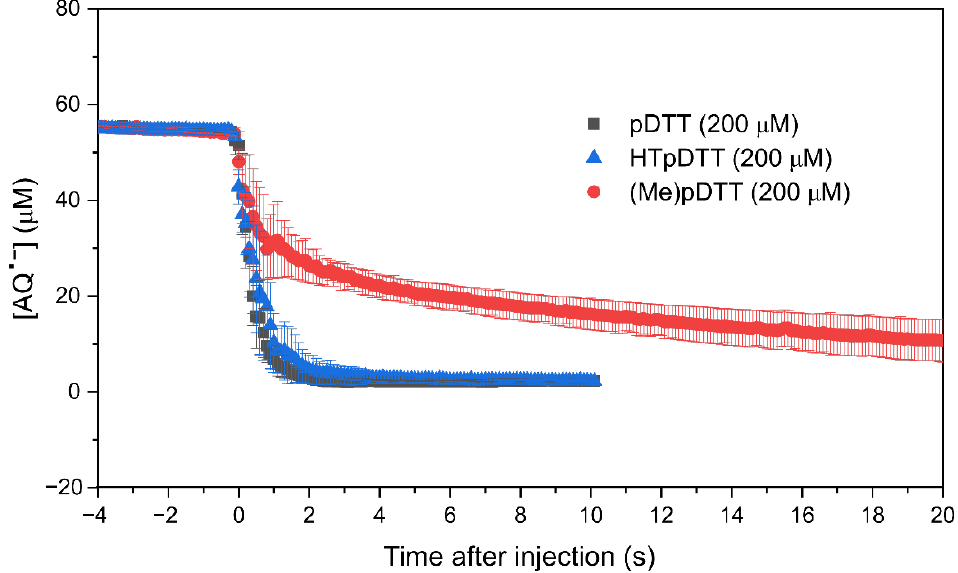
Figure 4. Traces showing change in [ AQ• − ] with time upon adding 100 μL polymer solution (at time = 0 s), resulting in 200 μ M polymer concentrations (pDTT black, HTpDTT blue, (Me)pDTT red) in 0.1 M Bu 4 NBF 4 /DMF. Uncertainties are calculated using triplicates.